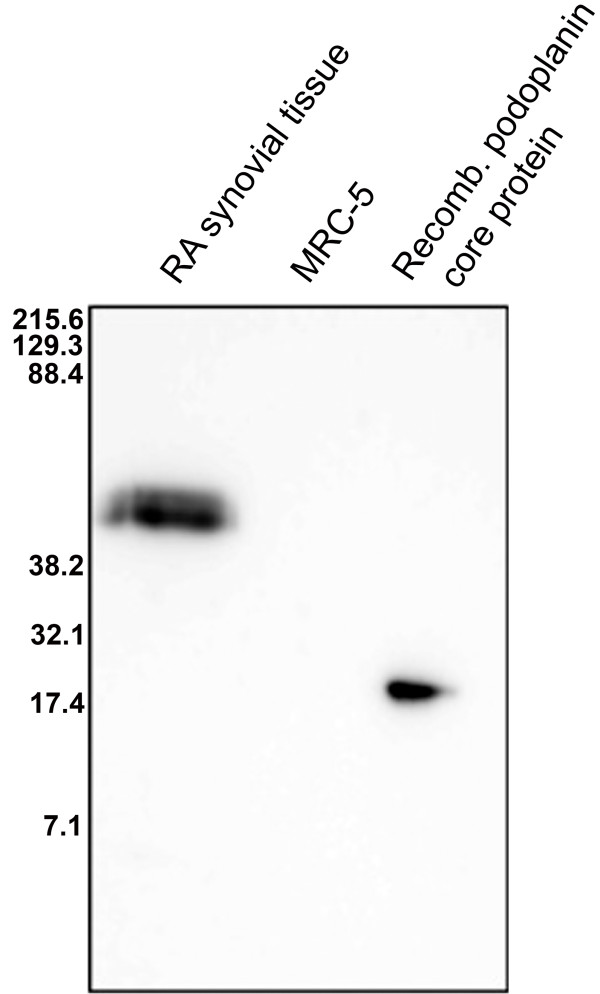
Anti-podoplanin antibody D2-40 recognizes 45kD band in Western blot of synovial protein extracts. Western blot of extracted membrane proteins from human synovial tissue from a patient with rheumatoid arthritis (RA) (lane 1), cell pellet of human MRC-5 lung fibroblast cell line (lane 2) and recombinant immature podoplanin core protein (lane 3) separated on a 20% sodium dodecyl sulphate polyacrylamide gel electrophoresis gel probed with the antipodoplanin antibody (D2-40).